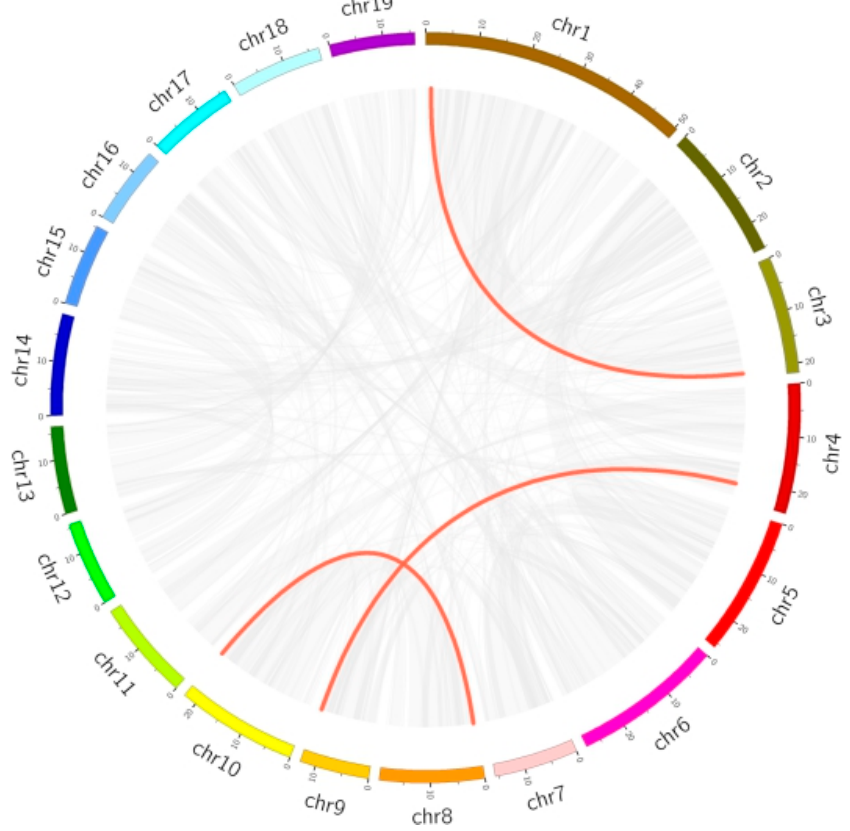
Figure 6. Genome-wide synteny analysis of PsnEIN3/EIL genes. chr1–19 represent chromosomes in Populus × xiaohei . All identified EIN3/EIL genes were mapped onto corresponding chromosomes. The red lines link the syntenic paralogs.